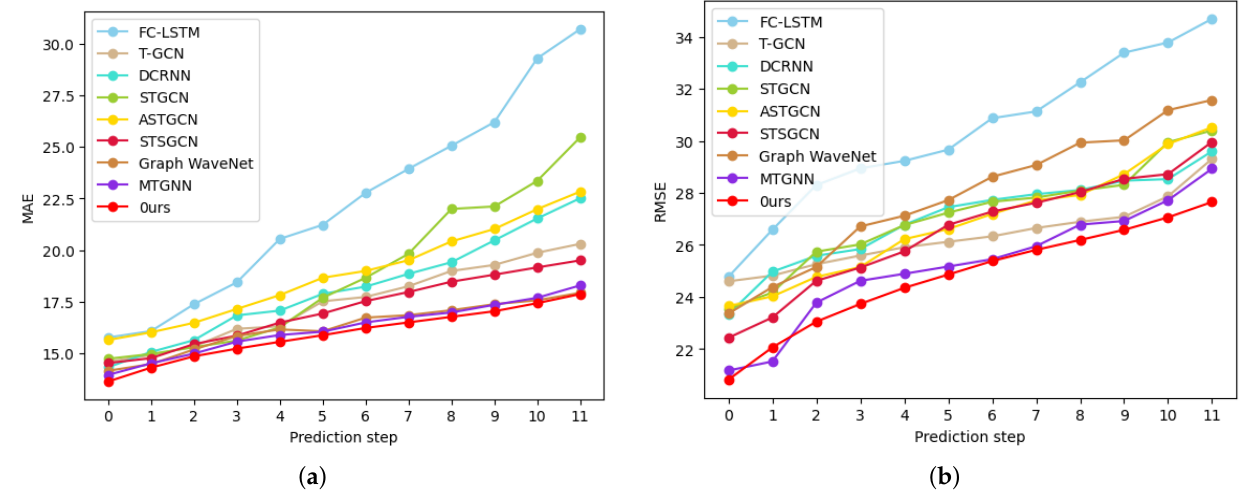
Figure 9. Comparison of each step error of all models on dataset PEMS08: ( a ) MAE; ( b )